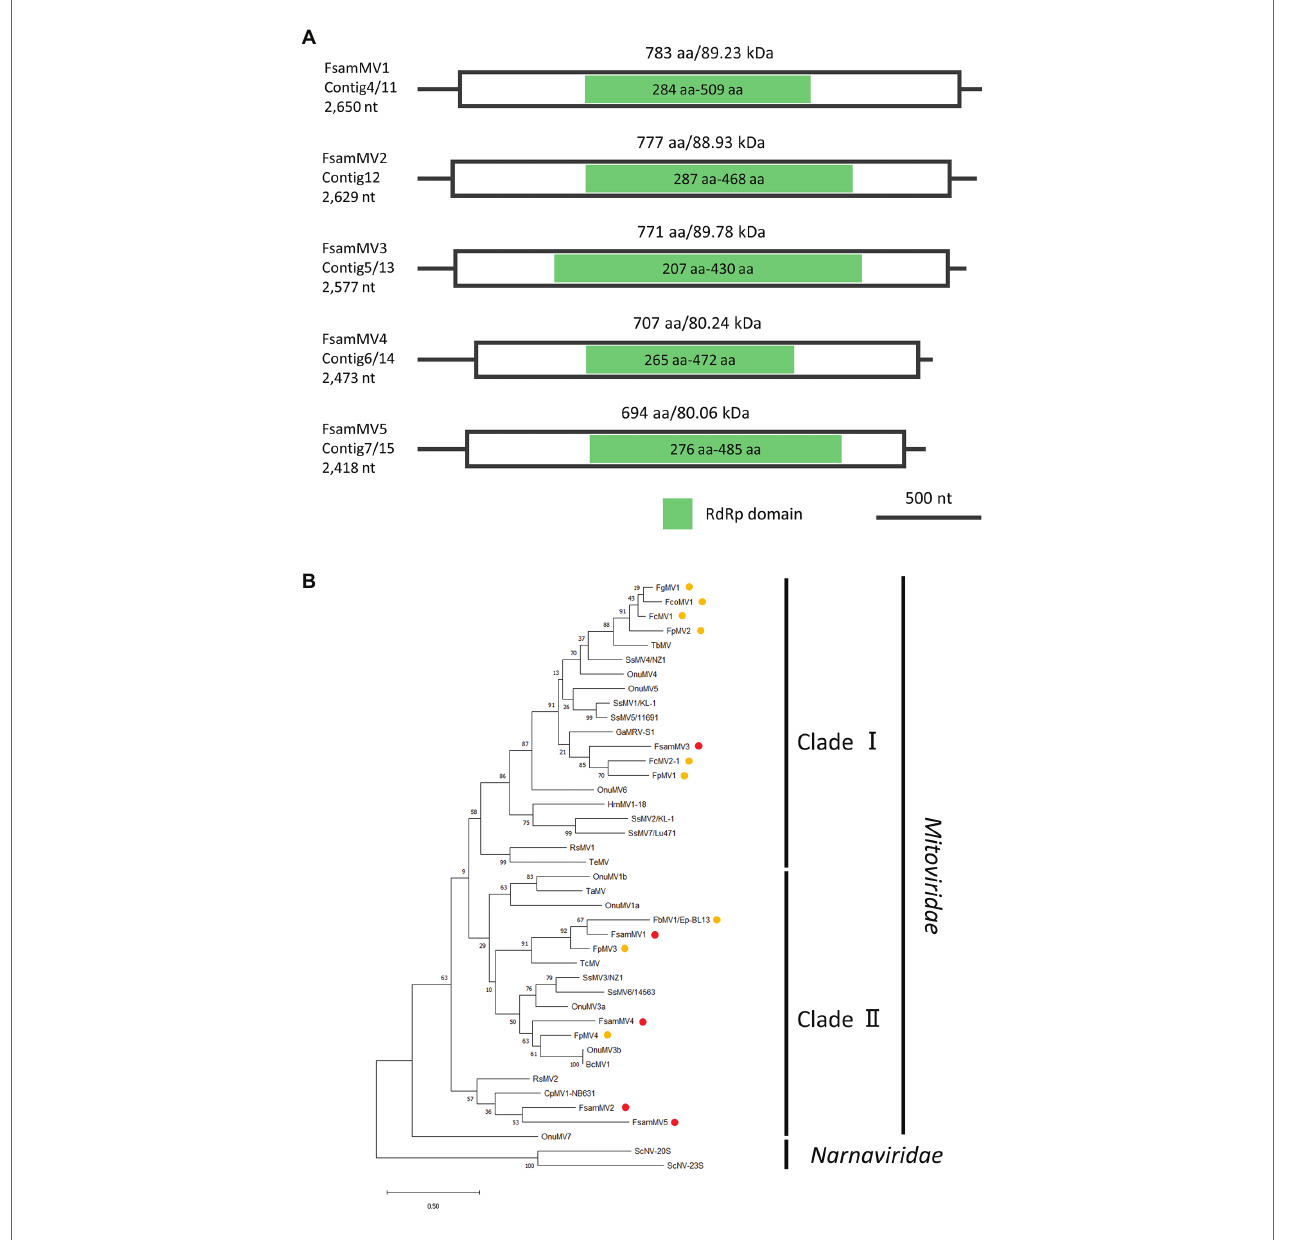
FIGURE 7 | Genome organization and phylogenetic placement of FsamMVs. (A) Schematic representations of the contigs of FsamMVs. White boxes indicate putative ORFs and green boxes indicate the conserved RdRp domain predicted by InterProScan. (B) An ML phylogenetic tree based on the multiple alignment of amino acid sequences of the conserved RdRp domain predicted on the putative replicases of five FsamMVs and other members of the Mitovirus genus. Two members of the Narnavirus genus were used as the outgroup. Red dots indicate FsamMVs, and yellow dots indicate mitoviruses of the Fusarium species. Bootstrap values obtained with 100 replicates are indicated on branches. Branch length corresponds to the genetic distance; the scale bar at the lower left corresponds to a genetic distance of 0.20. A list of accession numbers of the sequences and full virus names are summarized in Supplementary Table S2